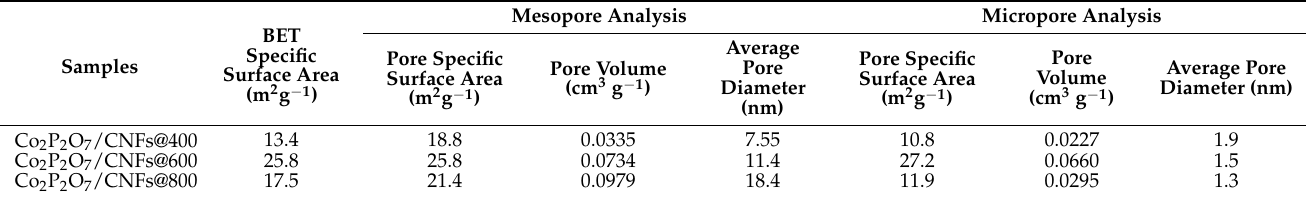
Summary of specific surface area, pore volume and average pore diameters of Co 2 P 2 O 7